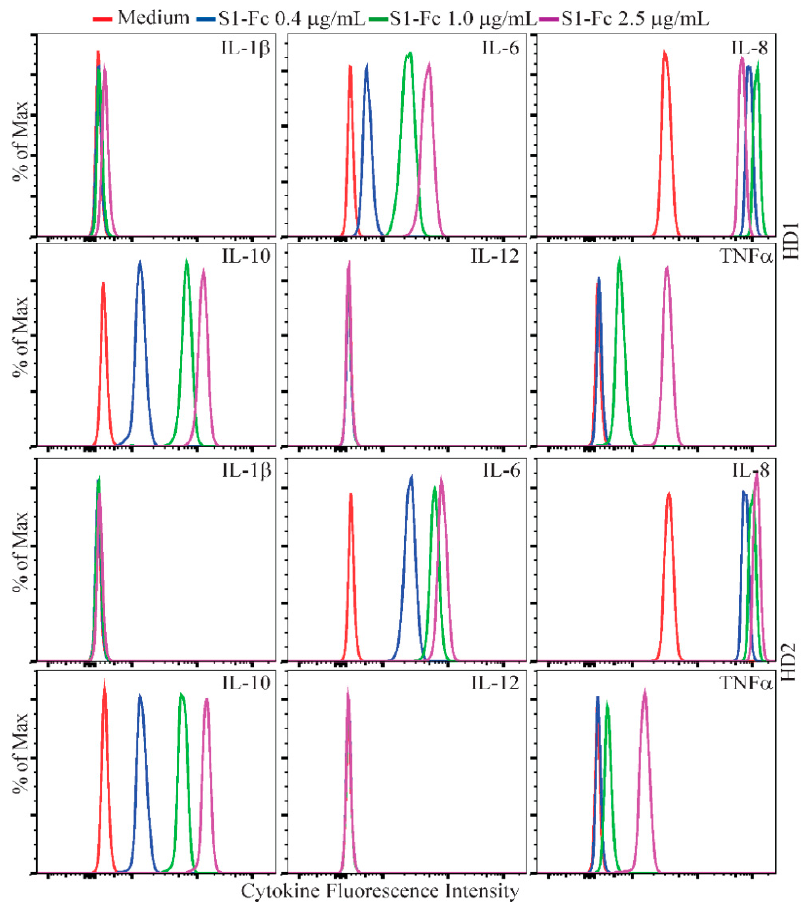
Figure 1. Dose-dependent cytokine responses of human PBMC induced by SARS CoV-2 S1-Fc fusion protein. Rested PBMC from two healthy donors (HD1 and HD2) were cultured for 48 h with 0, 0.4, 1.0 and 2.5 µ g/mL of S1-Fc purchased from Vendor #1 (lot 24056-2002-2). The levels of IL-1 β , IL-6, IL-8, IL-10, IL-12 and TNF α in the supernatants of cultured PBMC were assessed using the CBA human inflammatory cytokine kit and flow cytometric analysis. Data shown are representative of the flow cytometric results from at least two separate experiments performed on samples from healthy donors, HD1 and HD2.